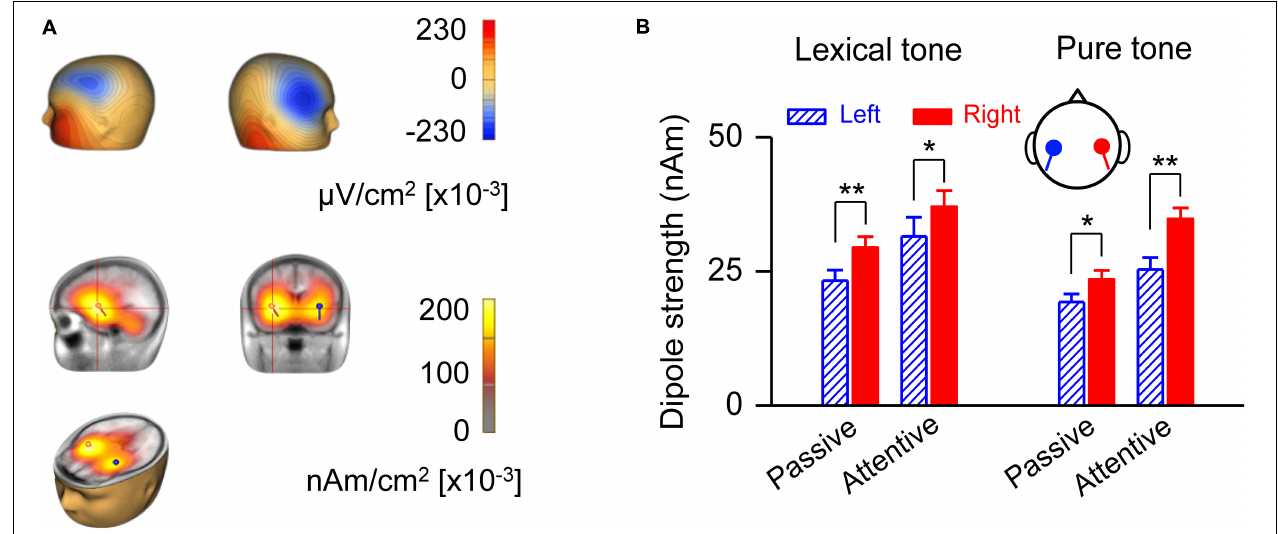
FIGURE 3 | Analysis of MMN source strength in the two hemispheres. (A) Scalp current density topography at the peak of global field power of grand-averaged MMN in response to lexical tone contrasts under the attentive condition (upper panel). Source localization estimated by Local Auto Regressive Average and dipole solution of MMN in response to lexical tone contrasts under attentive condition (lower panel). (B) Average dipole strengths obtained from dipole solutions for individual subjects. Asterisks indicate a statistically significant difference. ∗ P < 0.05; ∗∗ P < 0.01. Vertical lines represent one standard